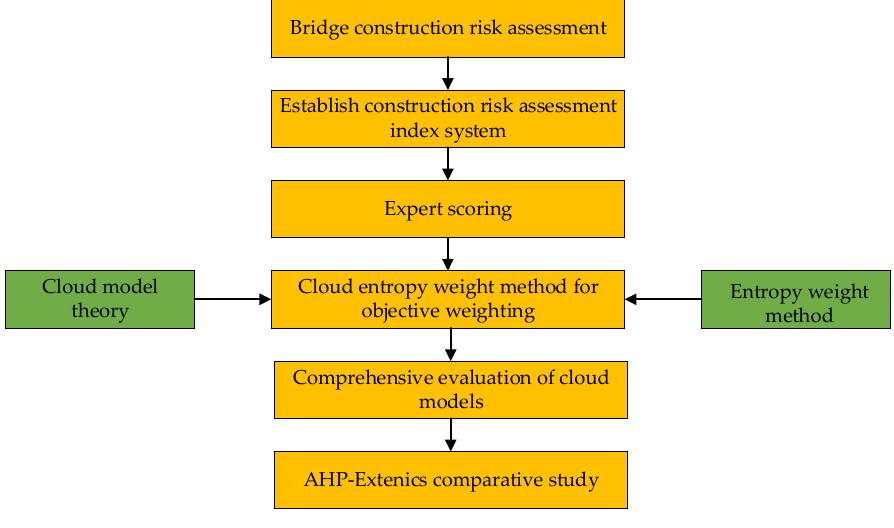
Figure 1. Flow chart of the study.